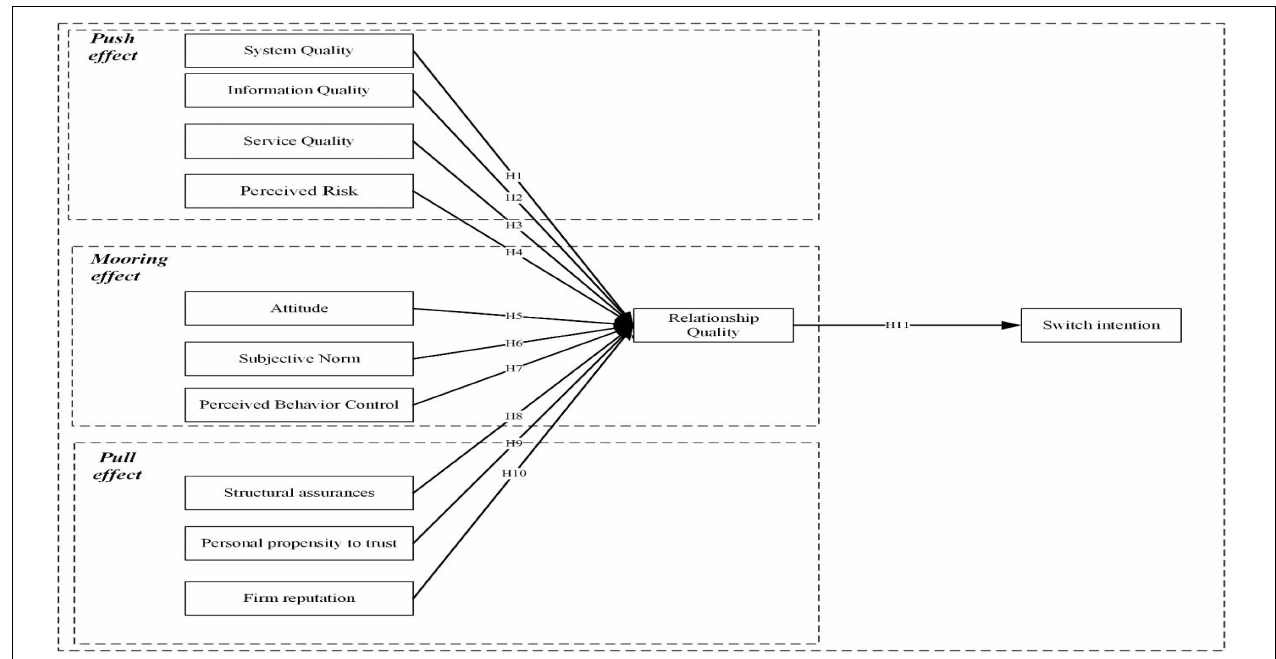
FIGURE 1 | Results of the inner